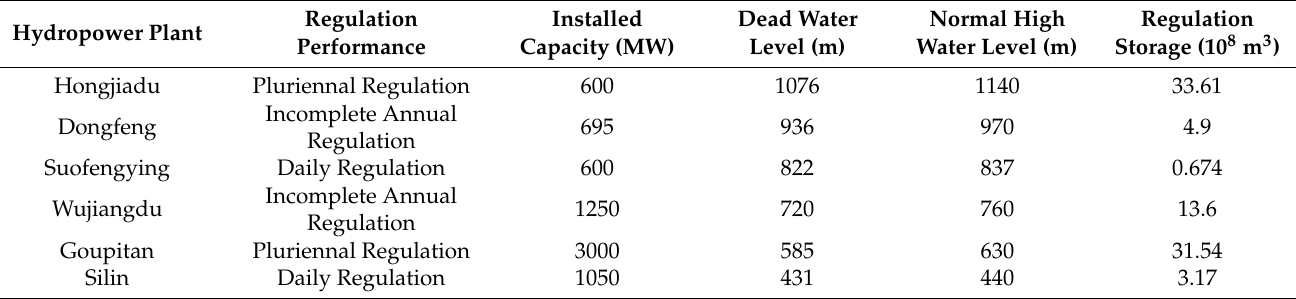
Table 1. Basic Parameters of Each Reservoir of Wujiang